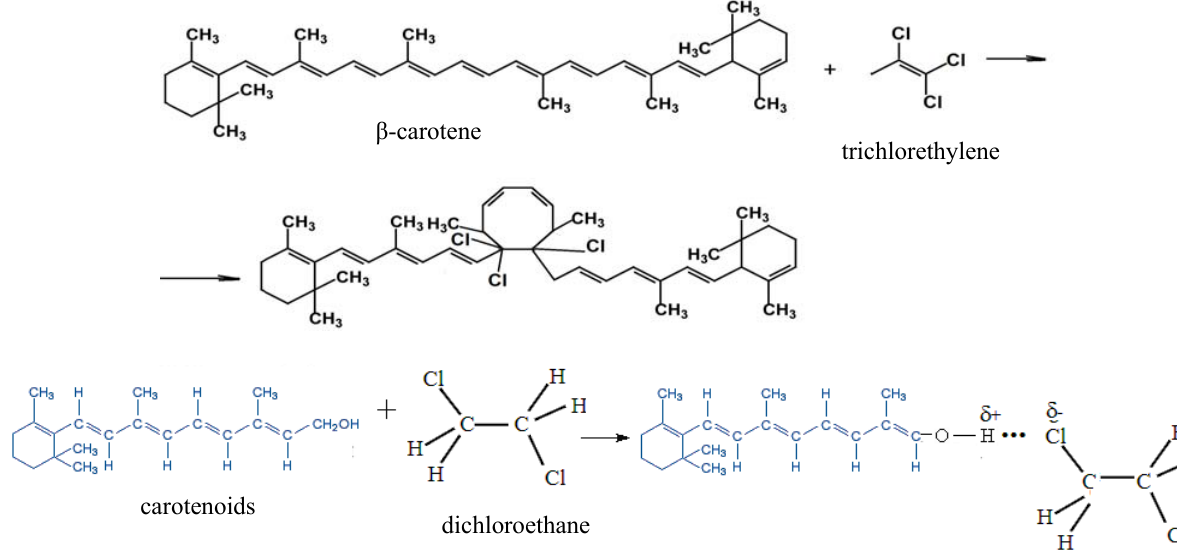
Fig. 13. Chemical interaction of carotenoids with the priority contaminants contained in water. Table 5. Vitamin content in the studied nectar samples, mg/100g